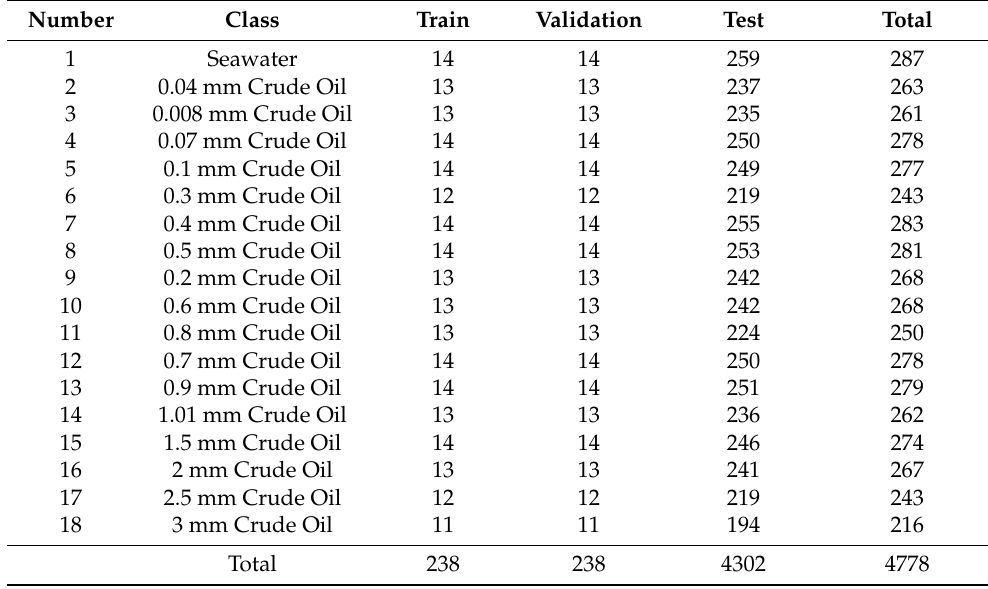
Table 3. Sample numbers of training, validation, and testing numbers in the oil film thickness